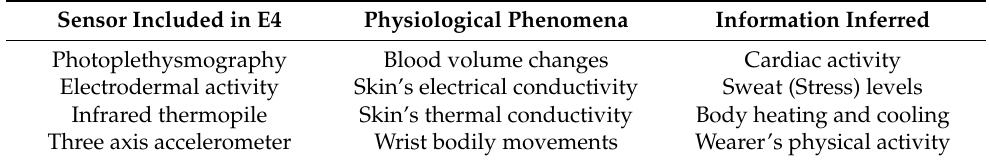
Figure 2. Scale down model of an autonomous hospital bed transport prototype was designed and tested. It included a set of motorized caster wheels and various autonomous navigation elements ( A-1 ). Prototype mockup of a patient wearing PPG wristbands on both wrists simultaneously ( A-2 ). Example of both PPG wristbands worn simultaneously on both hands of a subject using Empatica E4s (Empatica Inc., Boston, MA, USA) ( B,C ). Table 4. Empatica E4 wristband sensor breakdown. Sensor Included in